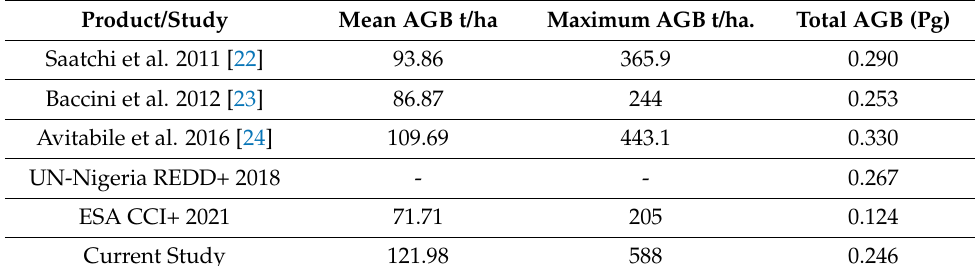
Table 3. Mean, maximum and total AGB by products and study over Cross River State, Nigeria. Product/Study